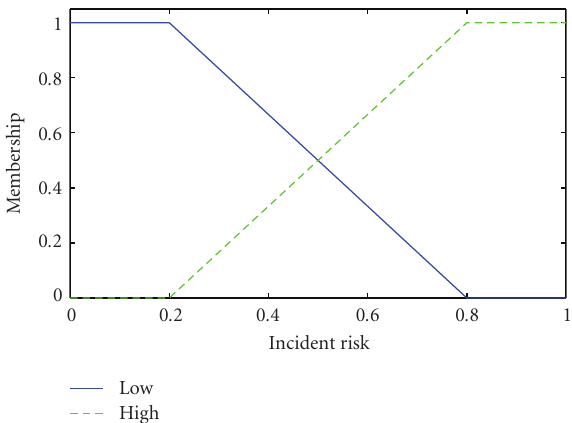
Figure 9: Membership function of “Incident Risk” parameter.